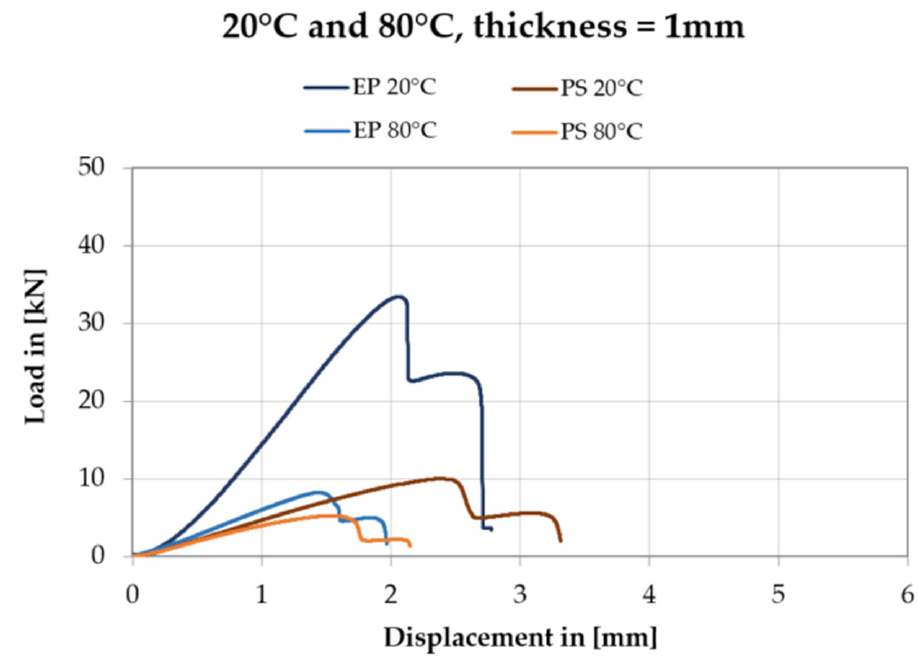
Figure 15. Force vs. displacement plots for Sika ® PS and EP 2579-1 adhesives with the thickness t = 1 mm, at temperature 20 °C and 80 °C.